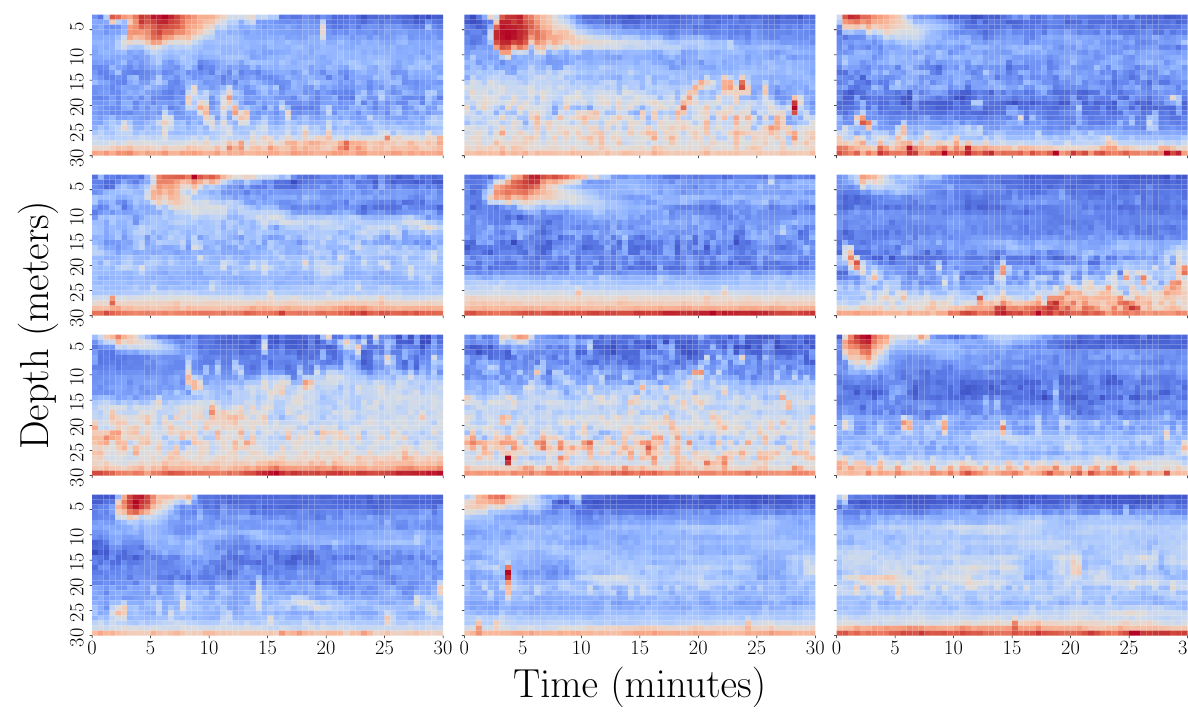
Figure 5. Examples of wakes labeled by the